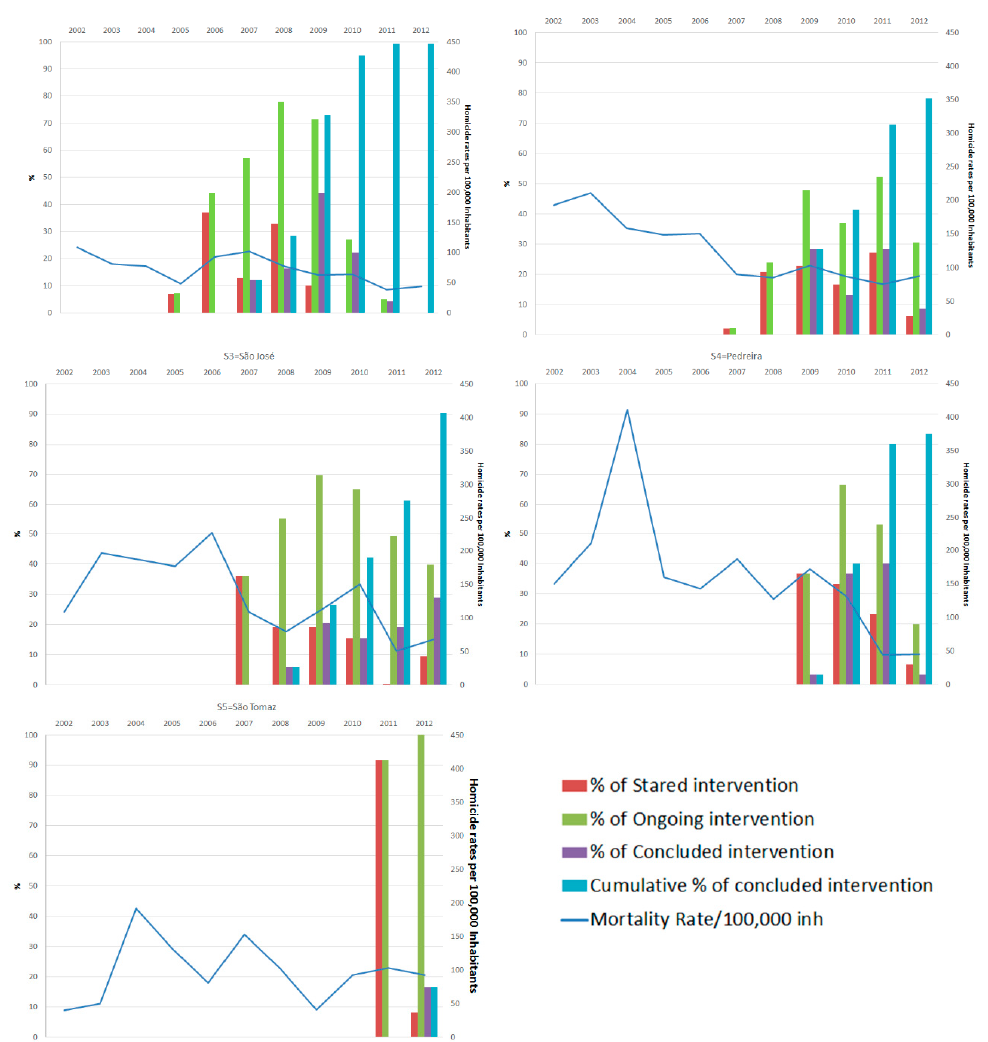
Figure 3. Timeline of Interventions and mortality rates of five slums in Belo Horizonte, 2002–12.